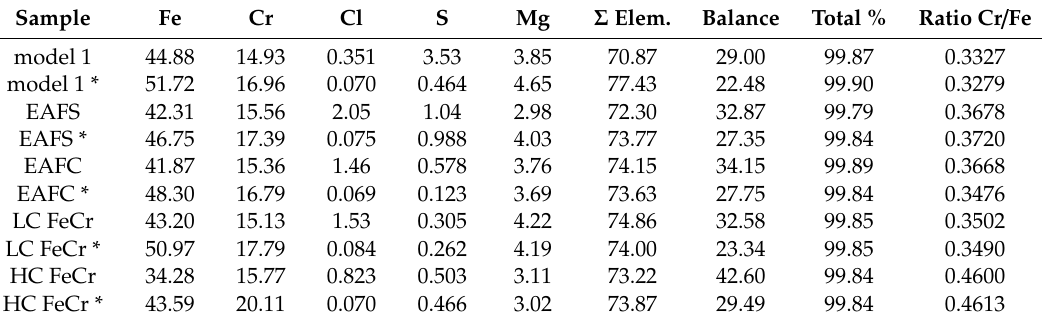
Table 3. XRF analysis results of EC solid products before and after (*) samples thermal treatment at 850 ◦ 850 °C.